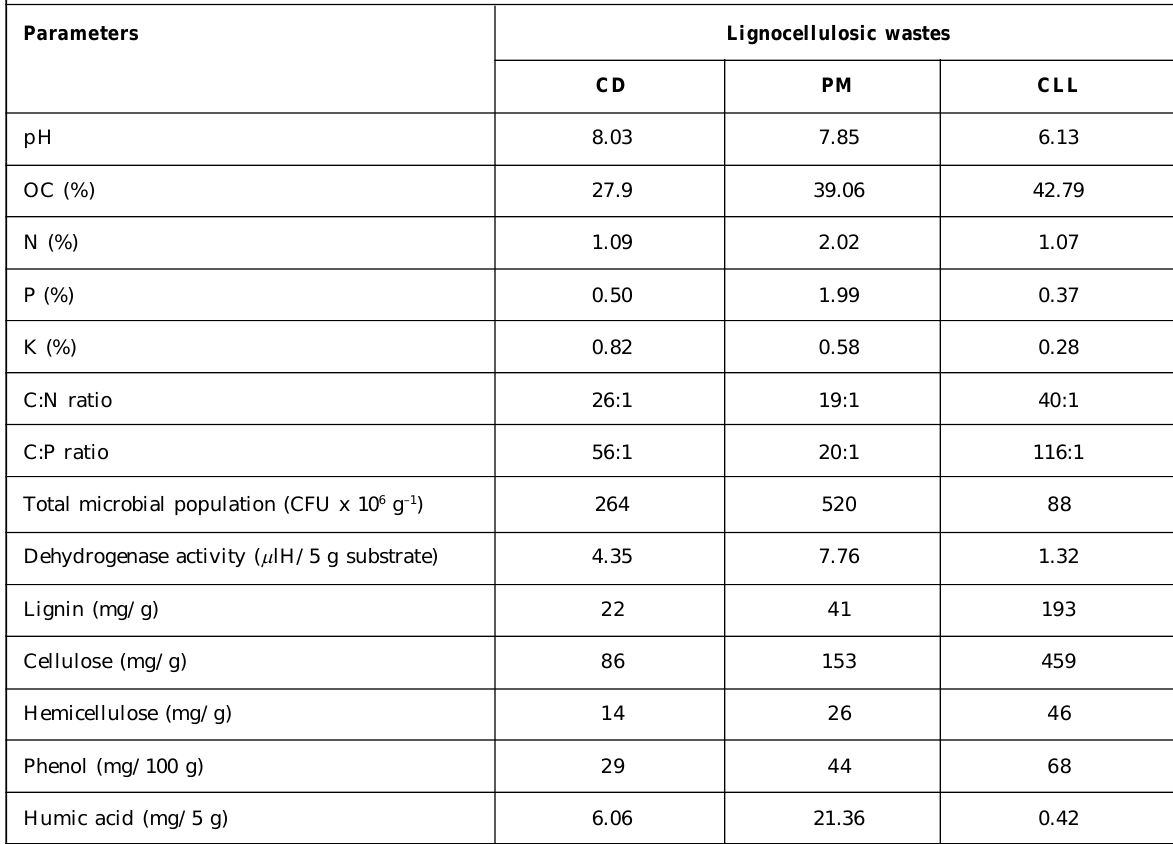
Table 2: Characteristic features of the raw materials used for experiments ( n =